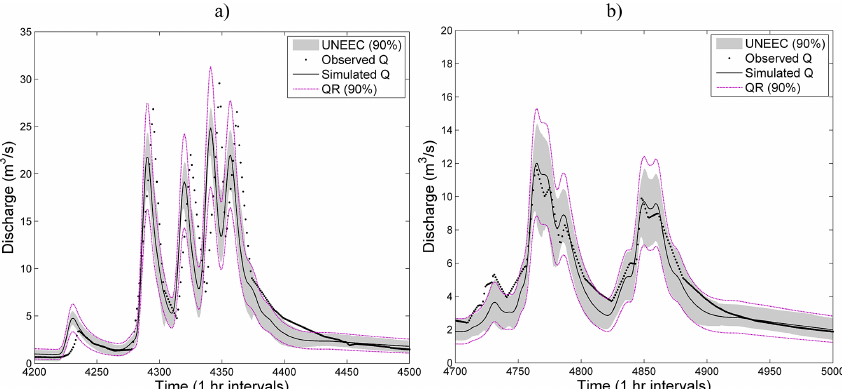
Figure 11. Comparison of prediction limits for the 90% confidence level during validation: (a) for the highest peak event (16 December 1995, 04:00UTC–28 December 1995, 16:00UTC), and (b) for a medium peak event (6 January 1996, 00:00UTC–18 January 1996,